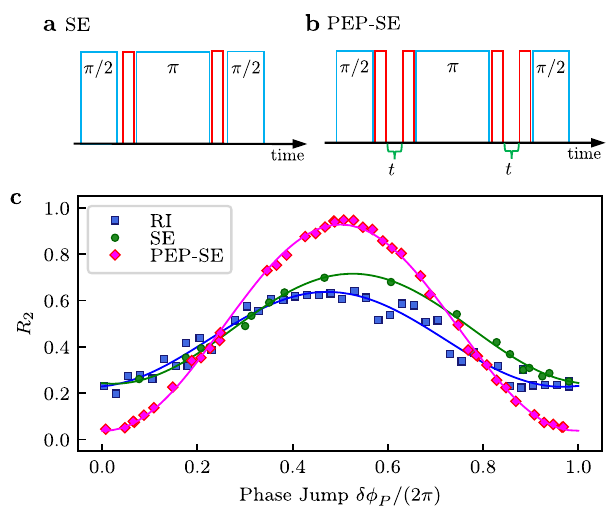
Fig. 3 Improved Ramsey interferometers. a , b Pulse sequences for spin- echo (SE) and pulse-evolve-pulse with spin-echo (PEP-SE) Ramsey interferometers. The red blocks denote the dispersive measurement pulses, and blue bars indicate the microwave pulses. c Interferometer signal measured using: a conventional Ramsey sequence (blue squares), a spin- echo Ramsey sequence (green circles), and a pulse-evolve-pulse with spin- echo sequence (magenta diamonds). All measurements were performed in situ at (cid:2) δ ¼ 63 : 4 with (cid:2) I (cid:9) 7 yielding g ≈ 1.